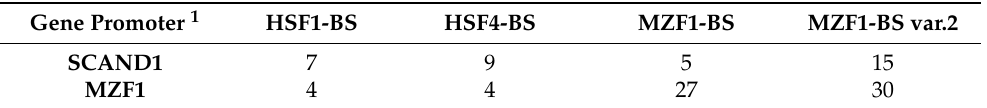
Table 1. The numbers of binding sites for HSF1, HSF4 and MZF1 in the promoter regions of SCAND1 and MZF1 genes. Gene Promoter 1